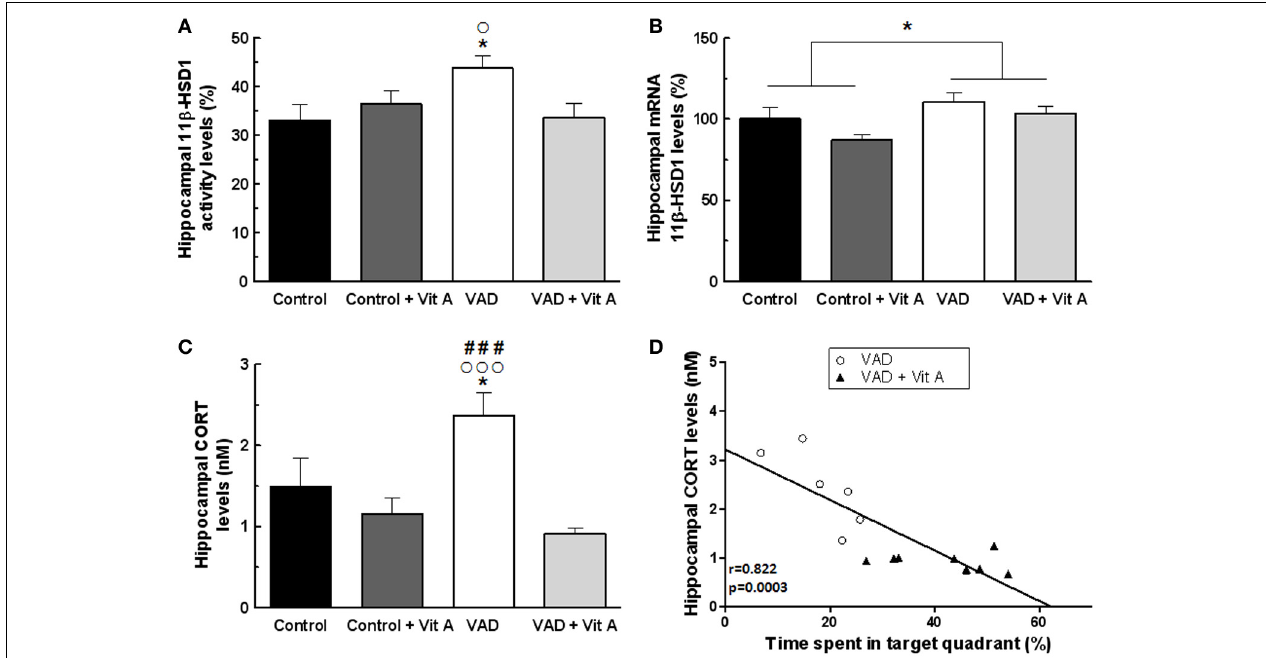
FIGURE 6 | Effects of 14 weeks of VAD and vitamin A supplementation on (A) activity and (B) mRNA expression of hippocampal 11 β -HSD1, (C) hippocampal CORT concentration. (A) The hippocampal 11 β -HSD1 activity is increased in VAD rats and is restored by vitamin A supplementation. (B) Similar effects are observed on the normalized ratio of 11 β -HSD1 mRNA expression. (C) VAD induces elevated levels of